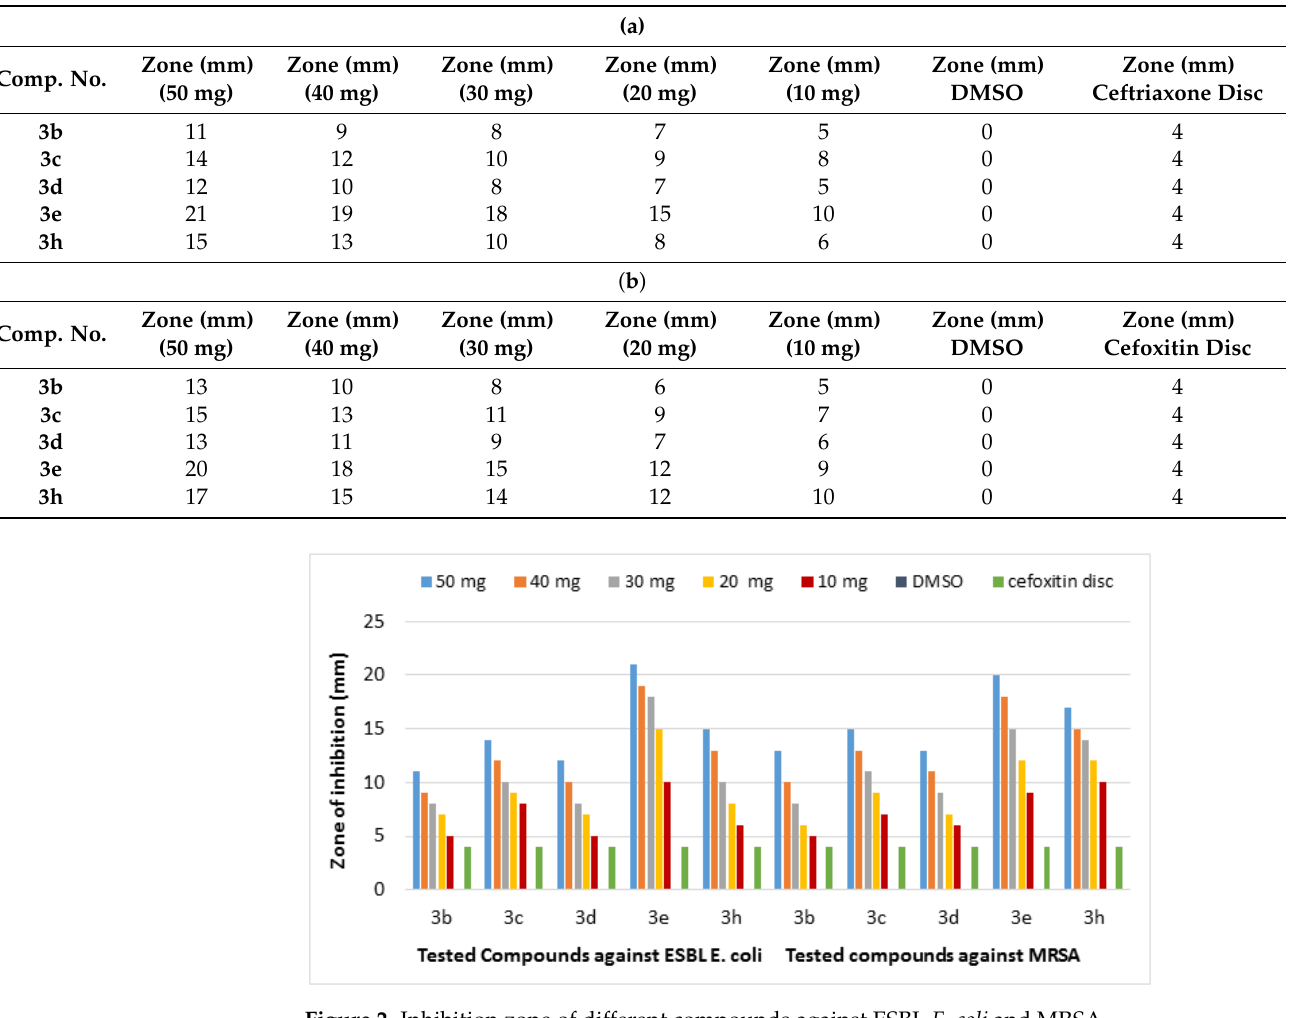
Figure 2. Inhibition zone of different compounds against ESBL E. coli and MRSA.